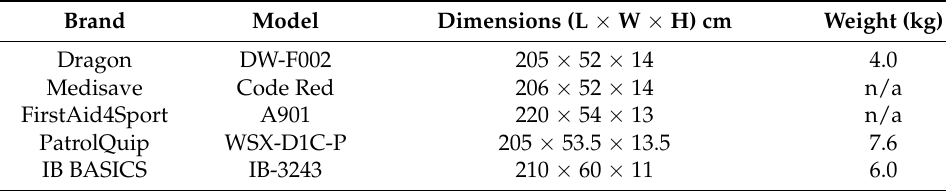
Table 2. Dimensions and weight of different stretcher models.